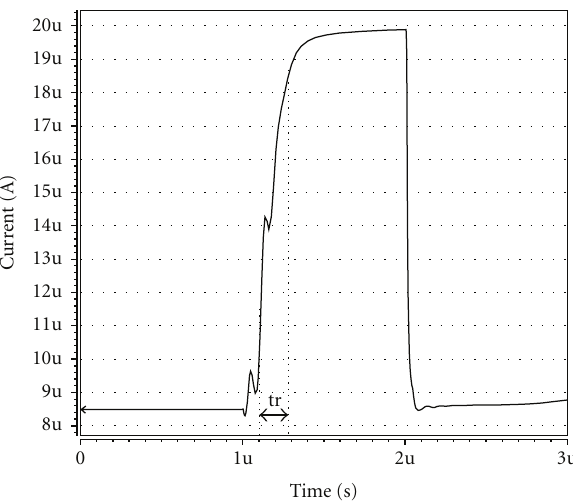
Figure 10: Temperature e ff ect on the fuzzy classifier Figure 8(a) for 7 di ff erent temperatures from − 25 ◦ C to 125 ◦ C and in 25 ◦ C steps (up to down with respect to these